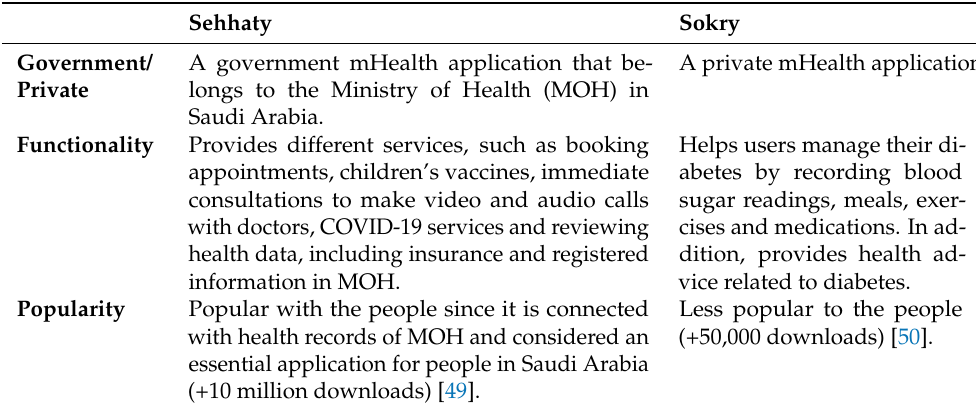
Table 8. Details of the “Sehhaty” and “Sokry”